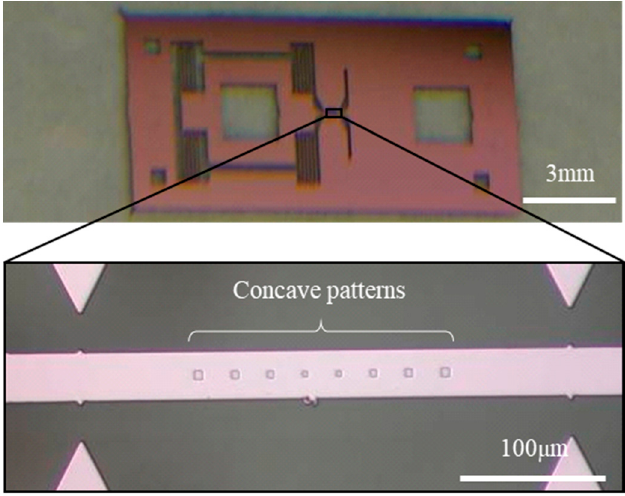
Figure 2. Photograph of a SiO 2 film specimen for the tensile loading test.